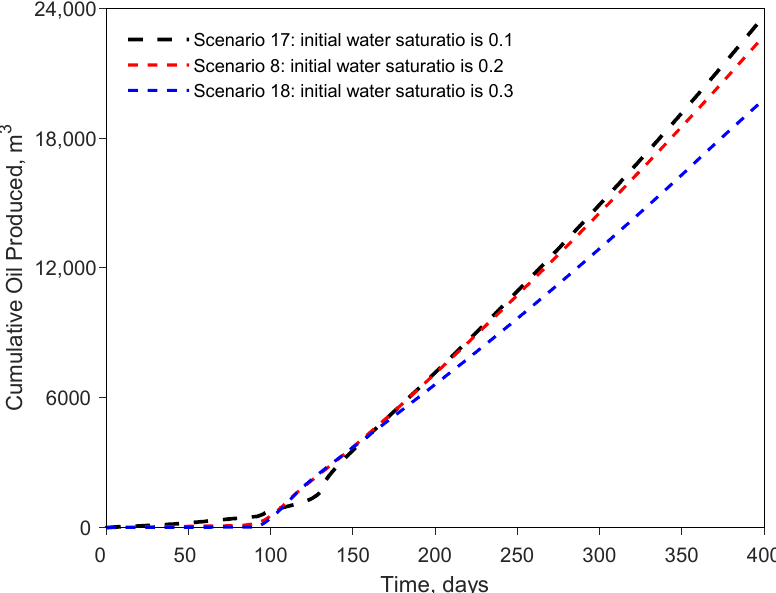
Figure 17. Cumulative oil production of scenarios 8, 17 and 18 under varying initial water satura- tion.